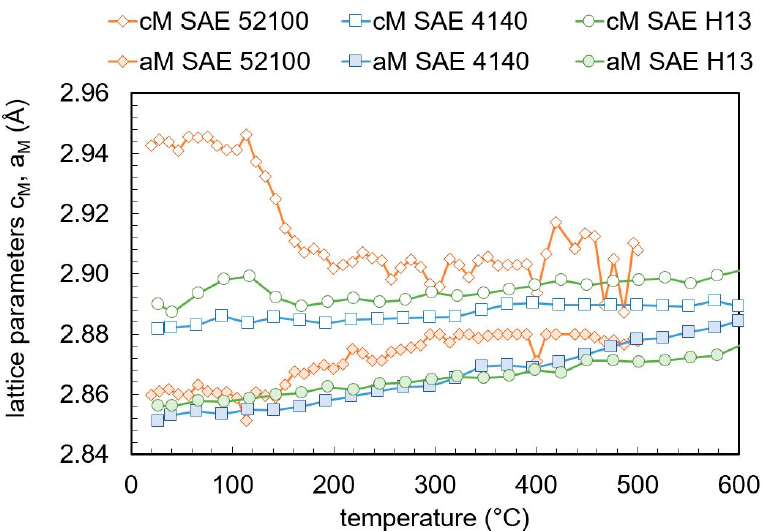
Figure 11. Evolution of martensite lattice parameters during tempering determined by in-situ X-ray measurement.